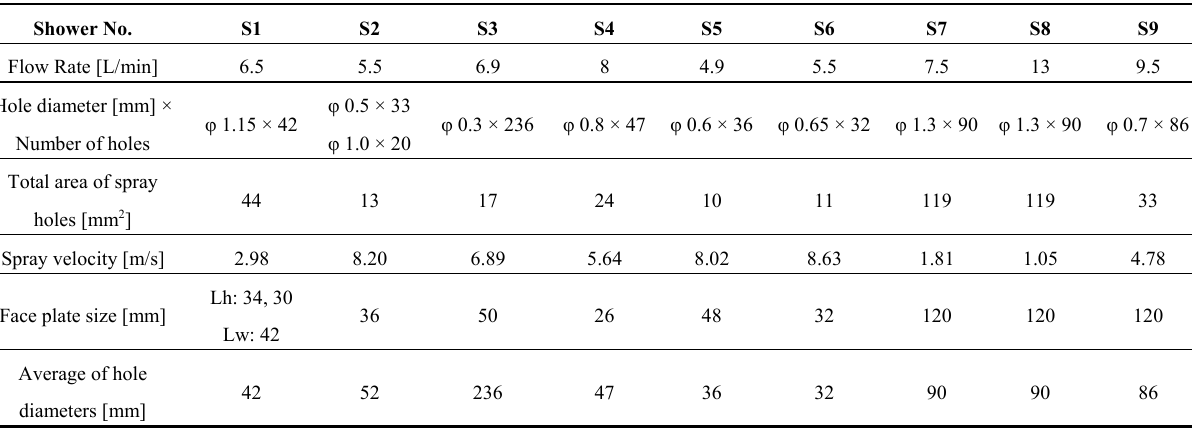
Table 1. Design value of showerheads and usage flow